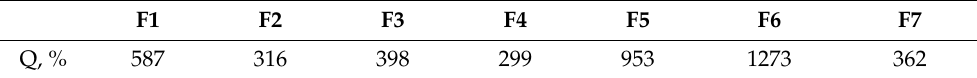
Table 2. The maximum swelling degree of the synthesized films.